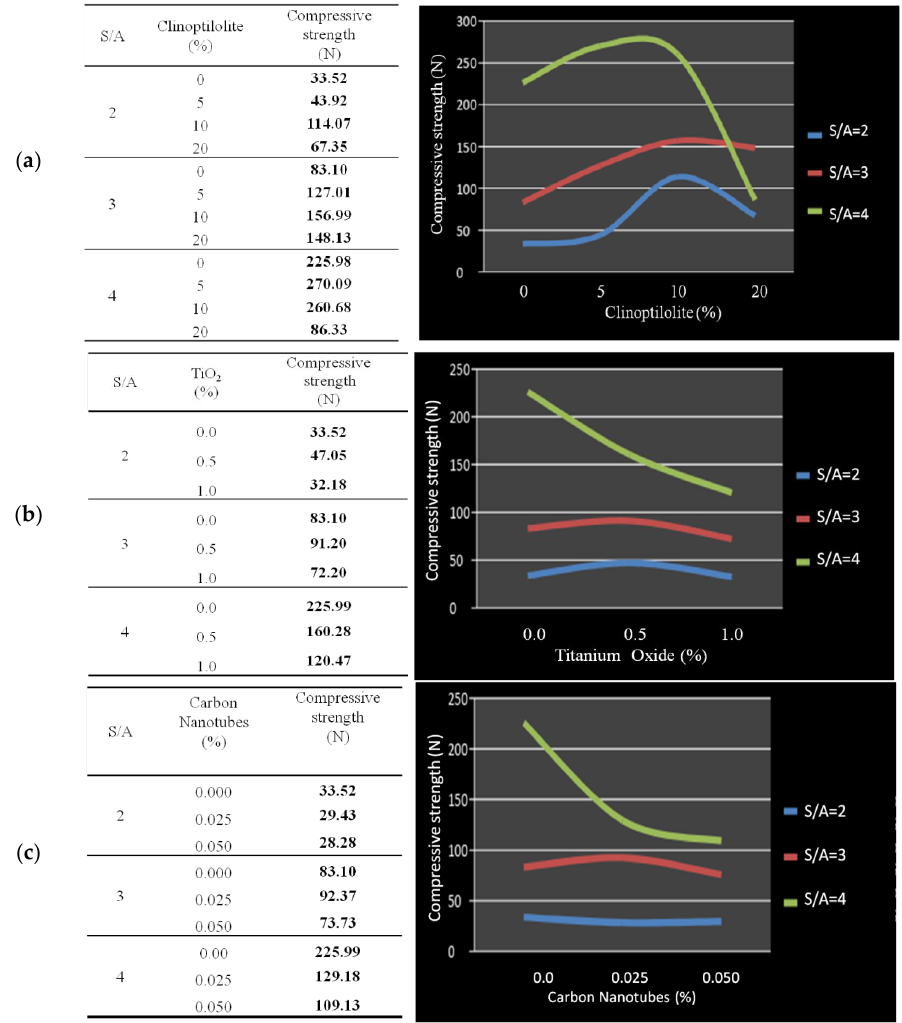
Figure 4. Compressive strength of the mortars obtained by varying the S/A ratio and the amount of additive for ( a ) clinoptilolite, ( b ) titanium oxide, ( c ) carbon nanotubes, respectively.